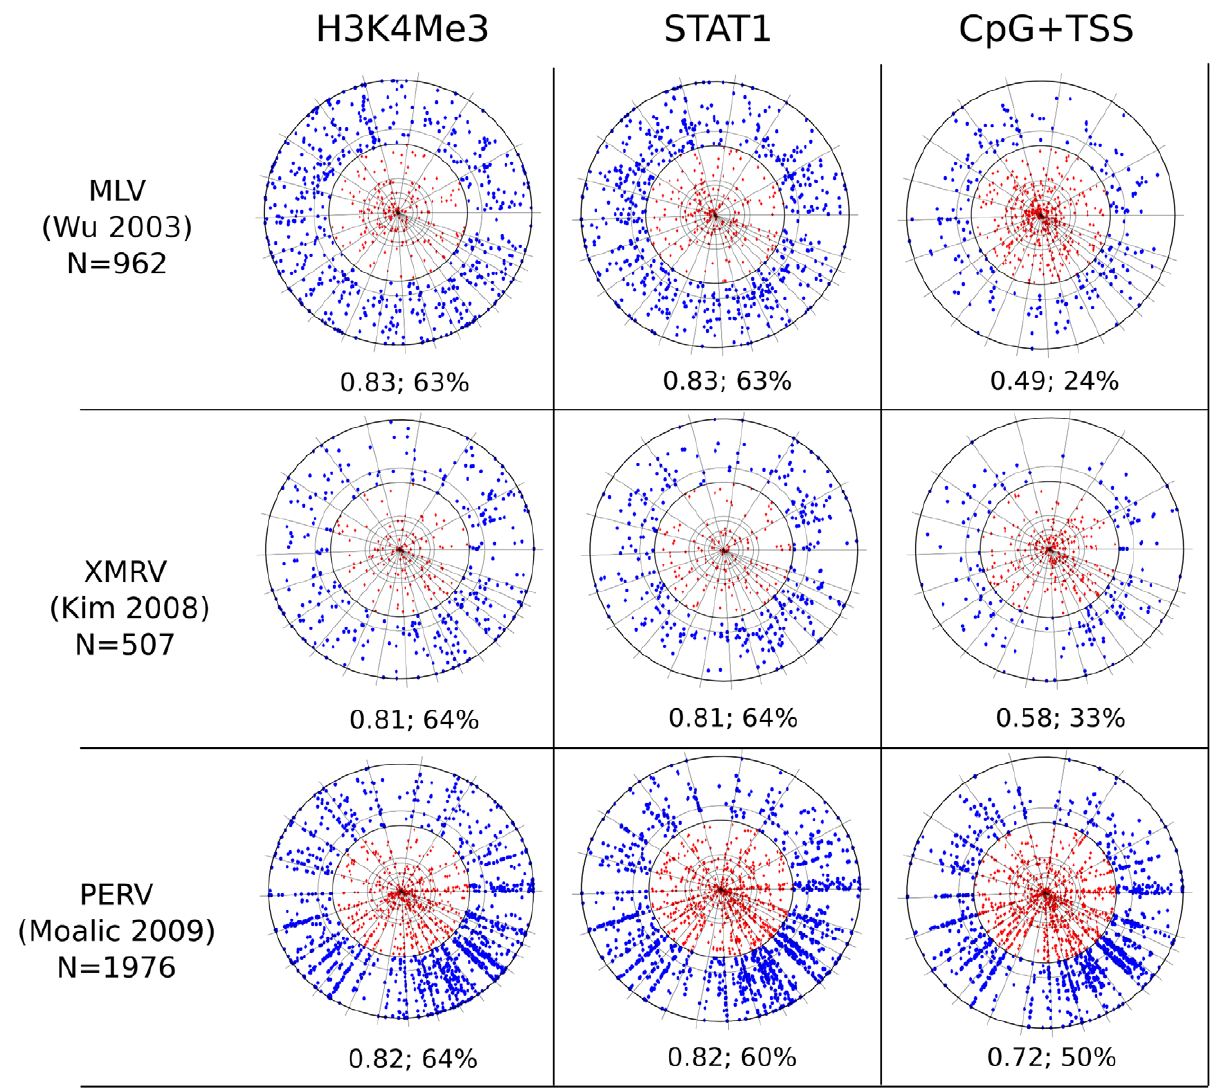
Figure 2. Chromosome projection mandala and F score calculated within 2 kB for the indicated markers (columns) versus the indicated proviruses (rows). The source of the provirus datasets is listed (see Table 2 and the text) and N indicates the number of proviruses considered for each analysis. MLV [31] proviruses were cloned from HeLa cells, XMRV proviruses from DU145, and PERV proviruses from HEK 293. H3K4me3 and STAT1 ChIPSeq datasets were from HeLa (see Table 1 and text). The F score and the percentage of proviruses within 2 kB are presented under each mandala.